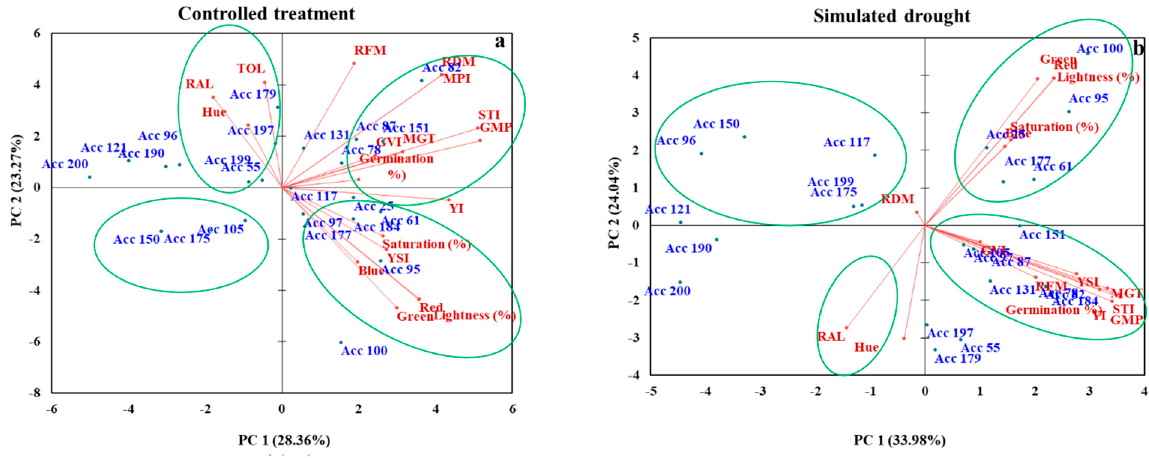
Figure 4. Biplot of drought indices, seed coat color, seed growth, and seed vigor based on the first two principal components axes (PC 1 and PC 2) for 24 Bambara genotypes in controlled treatment ( a ) and simulated drought conditions ( b ). SSI: stress susceptibility index, TOL: stress tolerance, MP: mean productivity, STI: stress tolerance index, GMP: geometric mean productivity, YI: yield index, YSI: yield stability index, RAL, Hue, Red: redness, Blue: blueness, Green: greenness., MGT: mean germination time, GVI: germination velocity index, RDM: roots dry mass, RFM, roots fresh mass.